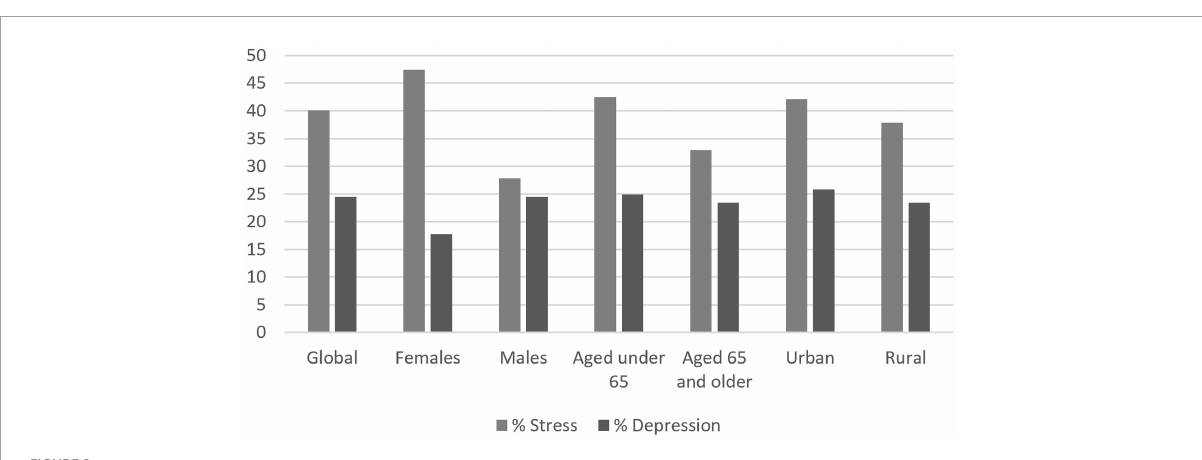
FIGURE1 Number of people screened by NL-IHRS categories and settings.